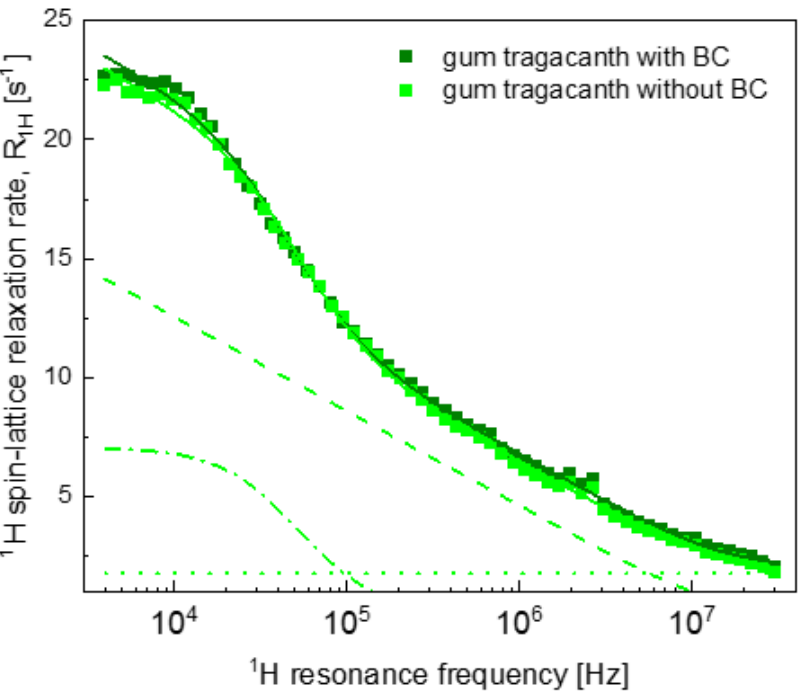
Figure 4. 1 H spin-lattice relaxation data for gum tragacanth hydrogels with and without BC. Figure 4. 1 H spin ‐ lattice relaxation data for gum tragacanth hydrogels with and without BC. Solid Solid lines—fits ( R 1, H ( ω H )) of Table 1. dashed line, R conf , intra lines—fits ( 𝑅 (cid:2869),(cid:3009) (cid:4666)𝜔 (cid:3009) (cid:4667)(cid:4667) of Table 1. dashed line, 𝑅 (cid:2869),(cid:3009)(cid:3030)(cid:3042)(cid:3041)(cid:3033),(cid:3036)(cid:3041)(cid:3047)(cid:3045)(cid:3028) (cid:4666)𝜔 (cid:3009) (cid:4667) —dashed–dotted line and 𝐴 —dotted A —dotted line. line.